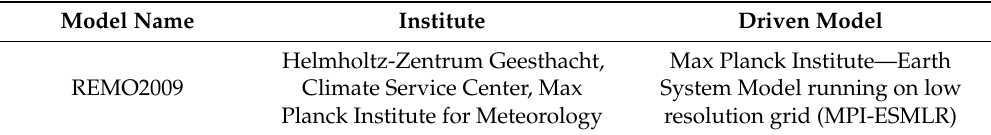
Table 1. Characteristics of the regional climate model (RCM),